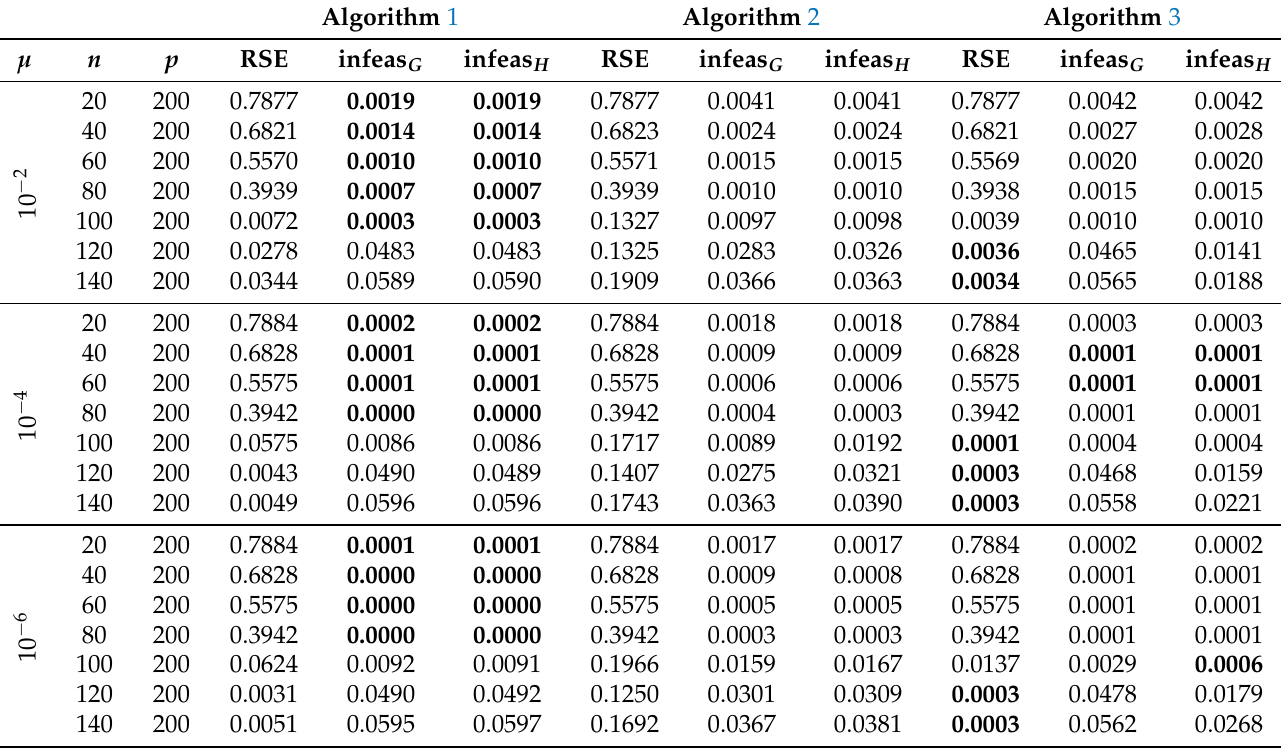
Table 6. This table contains numerical data obtained by running all three algorithms on the third dataset—BION data with three levels of noise, represented by µ ∈ { 10 − 2 ,10 − 4 ,10 − 6 } . The bold number is the smallest one in each